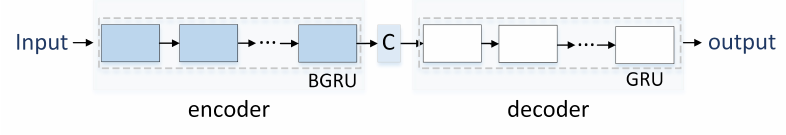
Figure 9. Seq2Seq network structure.